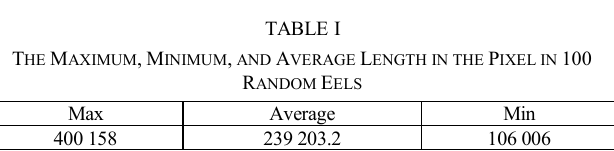
Fig. 8. A scatter plot to illustrate distribution in the length of 100 randomly selected